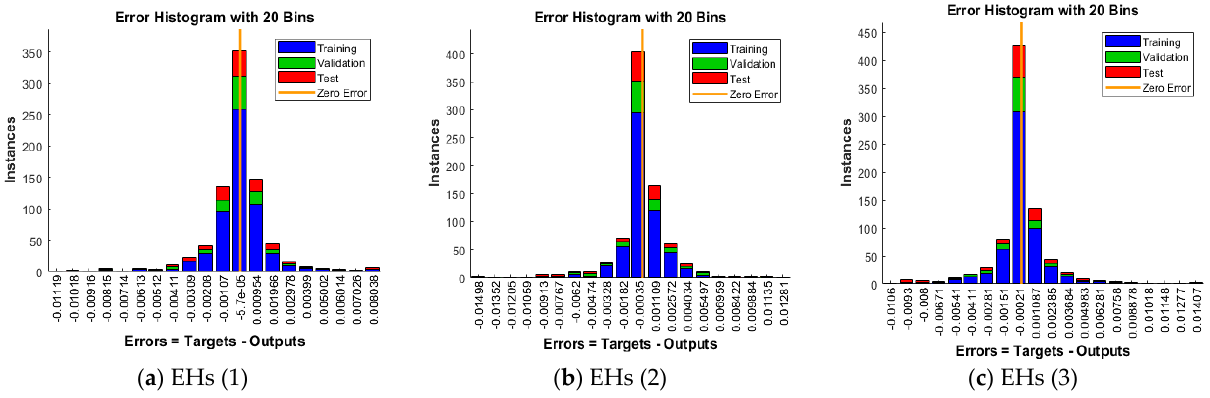
Figure 6. The performances of EHs for each case the nonlinear dynamics of MTS.